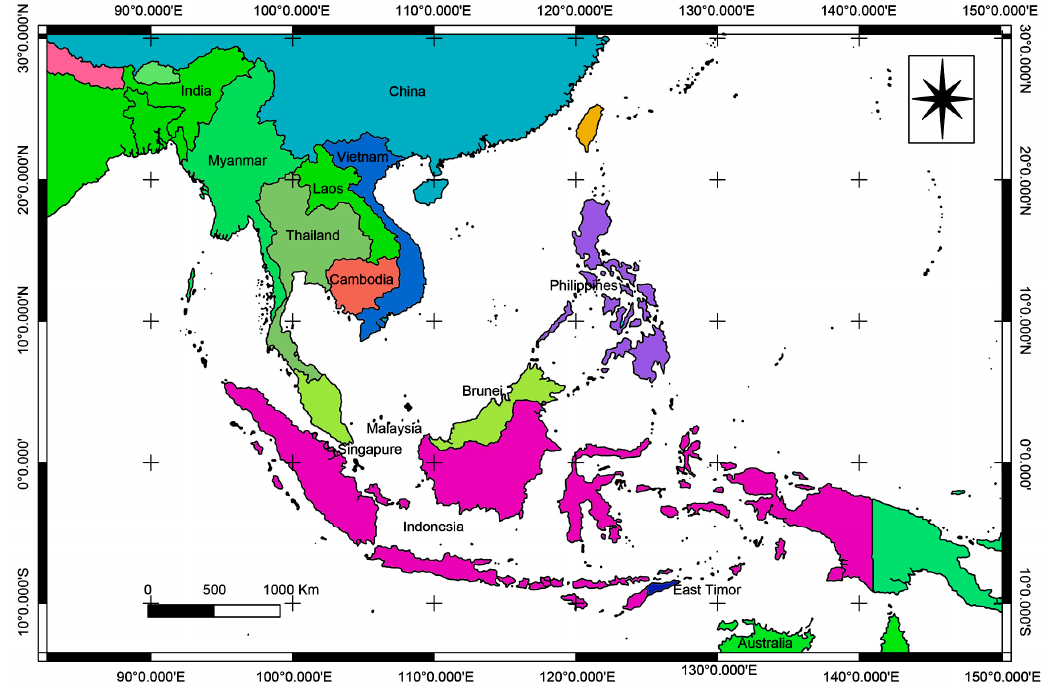
Figure 1. Map showing Southeast Asian countries.